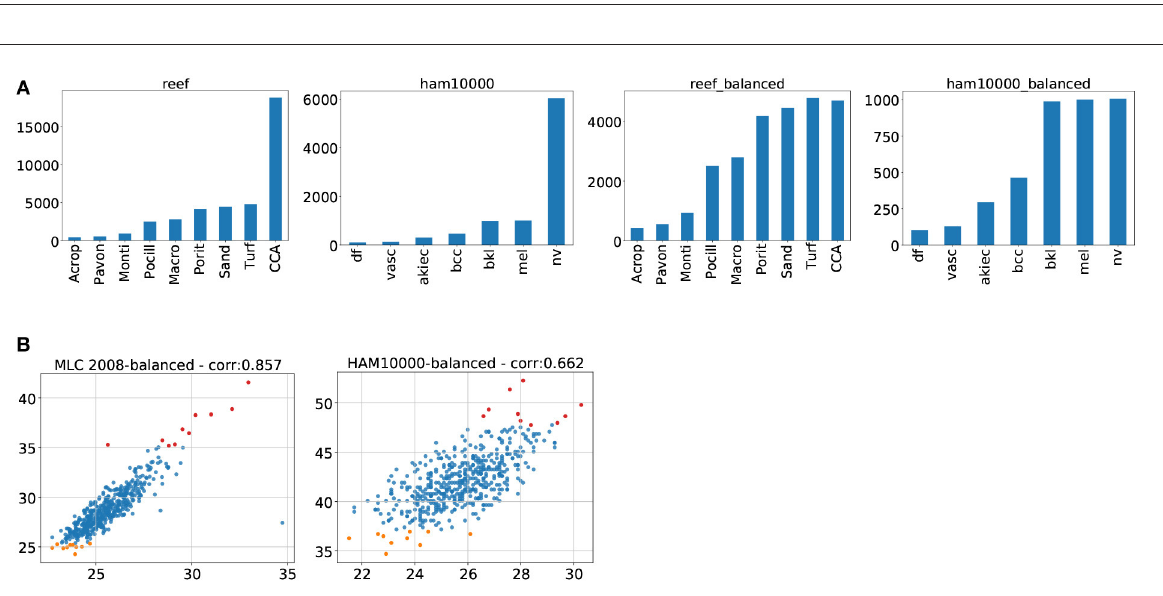
FIGUREA5 (A) Class distributions of MLC2008, HAM10000, and their balanced versions. (B) Errors of all 500 sampled architectures on MLC2008-balanced and HAM1000-balanced (y-axis) plotted against the errors of their unbalanced counterparts (x-axis). The top 10 performances on the target dataset are plotted in orange, the worst 10 performances in red. We observe a clear positive correlation for both datasets, hence we conclude that the dataset imbalance has a limited impact on the